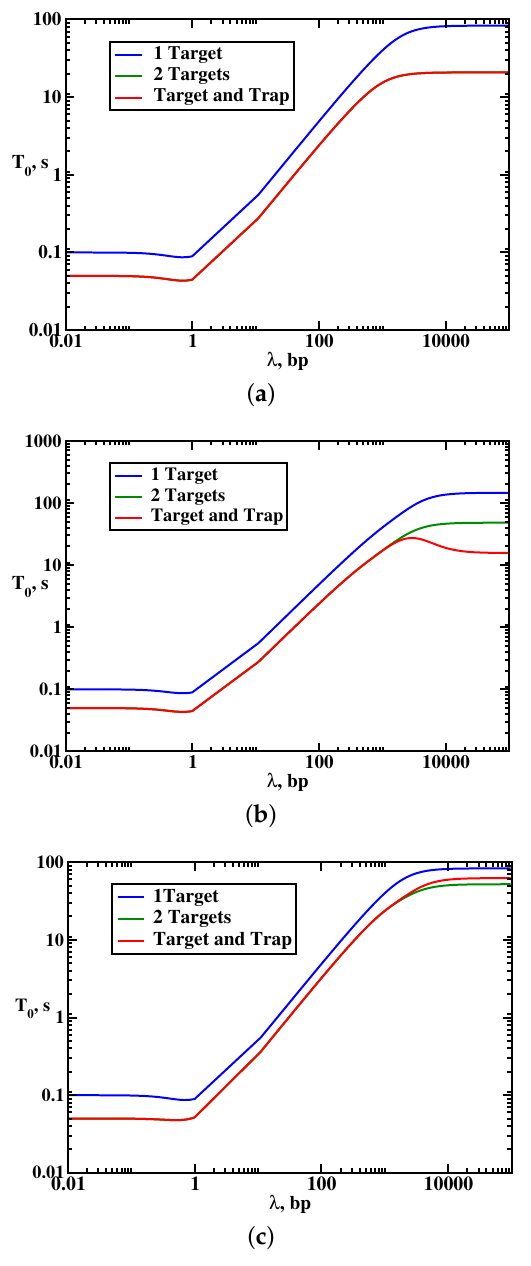
Figure 4. Dynamic phase diagrams for the protein search on DNA with one target at the position m , with two targets at the positions m 1 and m 2 and with the target and the trap at the positions m 1 and m 2 , respectively. Parameters used for calculations are: k on = u = 10 5 s − 1 and L = 10,000. ( a ) m = L /2, m 1 = L /4 and m 2 = 3 L /4; ( b ) m = L /4, m 1 = L /4 and m 2 = L /2; and ( c ) m = L /2, m 1 = L /2 and m 2 = L . Adapted with permission from Ref.